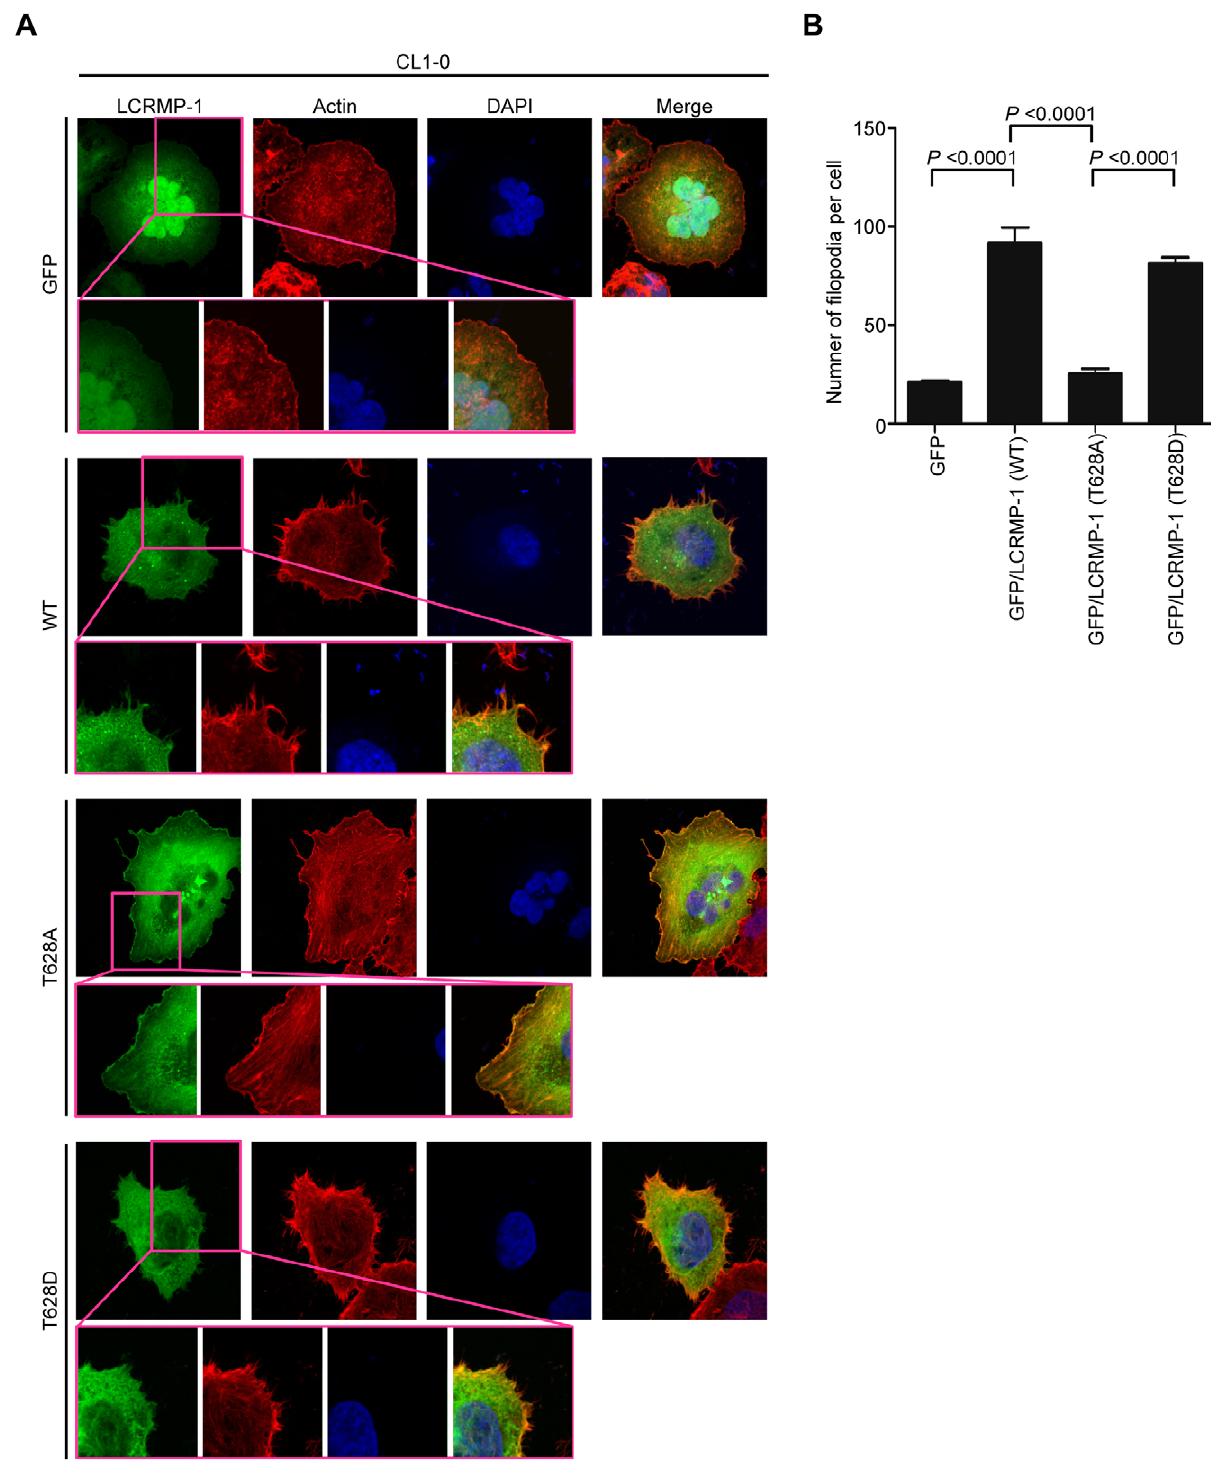
Figure 3. Phosphorylation of LCRMP-1 at Thr-628 is required for filopodia formation. (A) Nonphosphorylated LCRMP-1 (T628A) mutant impairs filopodia formation. CL1-0 cells were transiently transfected with GFP-tagged LCRMP-1 (WT), LCRMP-1 (T628A), and LCRMP-1 (T628D). At 24 hours after transfection, these cells were fixed, permeabilized and then immunostained with rhodamine-conjugated phalloidin (red) for actin and DAPI (blue) for visualizing nuclei. Representative immunofluorescence images were visualized using fluorescence microscope. Scale bar, 10 m m. Insets show higher magnifications (400 6 ). (B) Numbers of filopodia were counted with at least six cells per group. Data were presented as means 6 SEM.